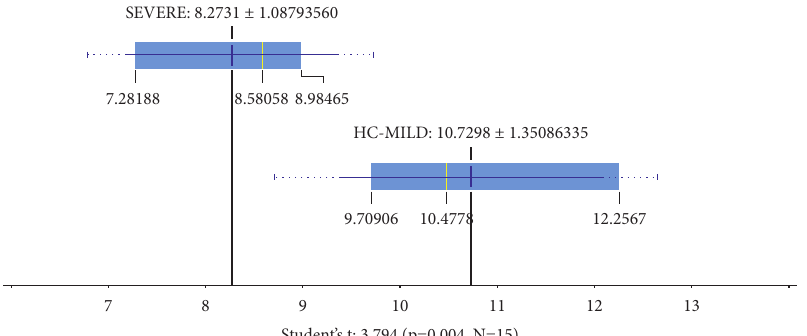
Figure 11: The mean IFNG expression in the SEVERE and MILD-HC groups was significantly different ( p ≤ 0 . 01 ) . It can be seen in the image that IFNG is downregulated that inhibits IFNG synthesis.